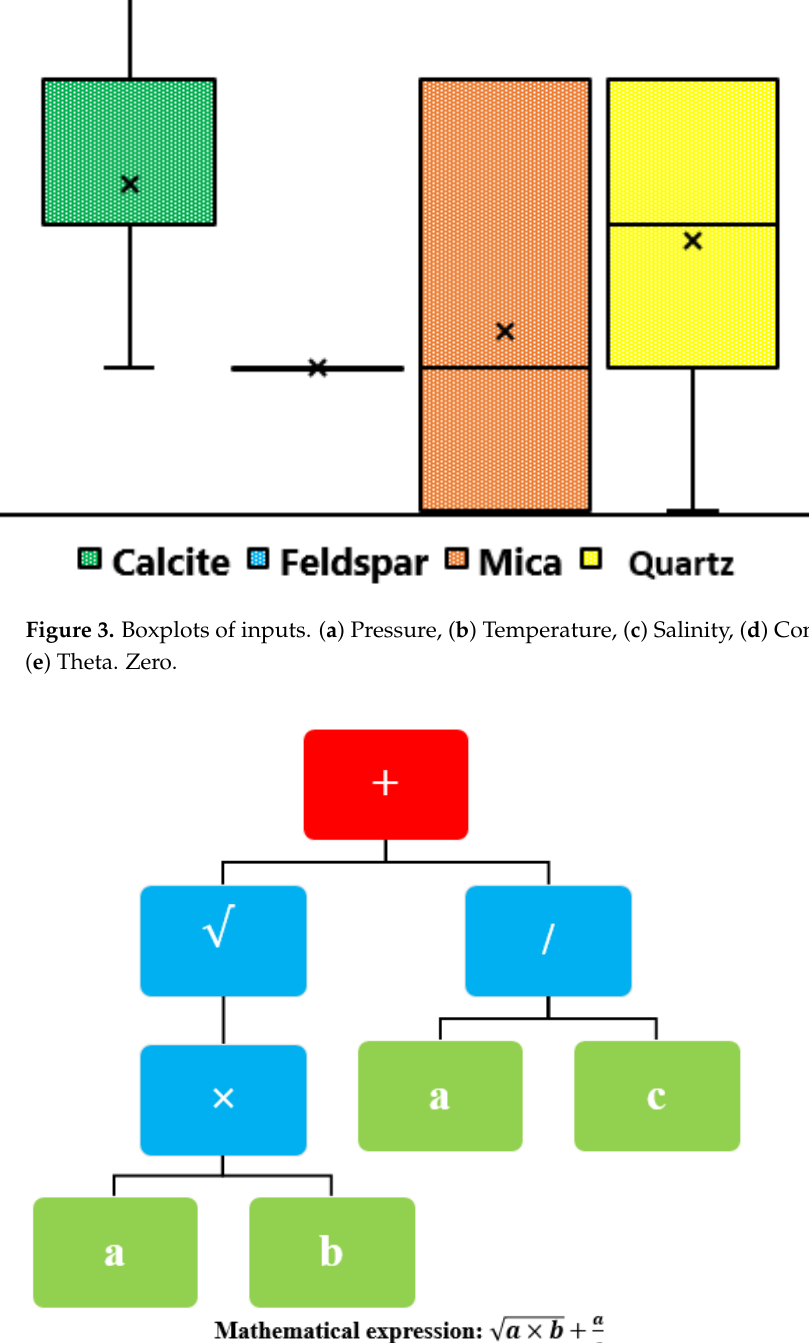
Figure 5. Flow chart diagram of the GEP algorithm. 2.3. Model Development In the present work, the selected experimental database was randomly divided into two parts, namely training and testing data sets, for developing the GEP model. Hence, 80% of the total data was used as the train set, while the remaining 20% was considered